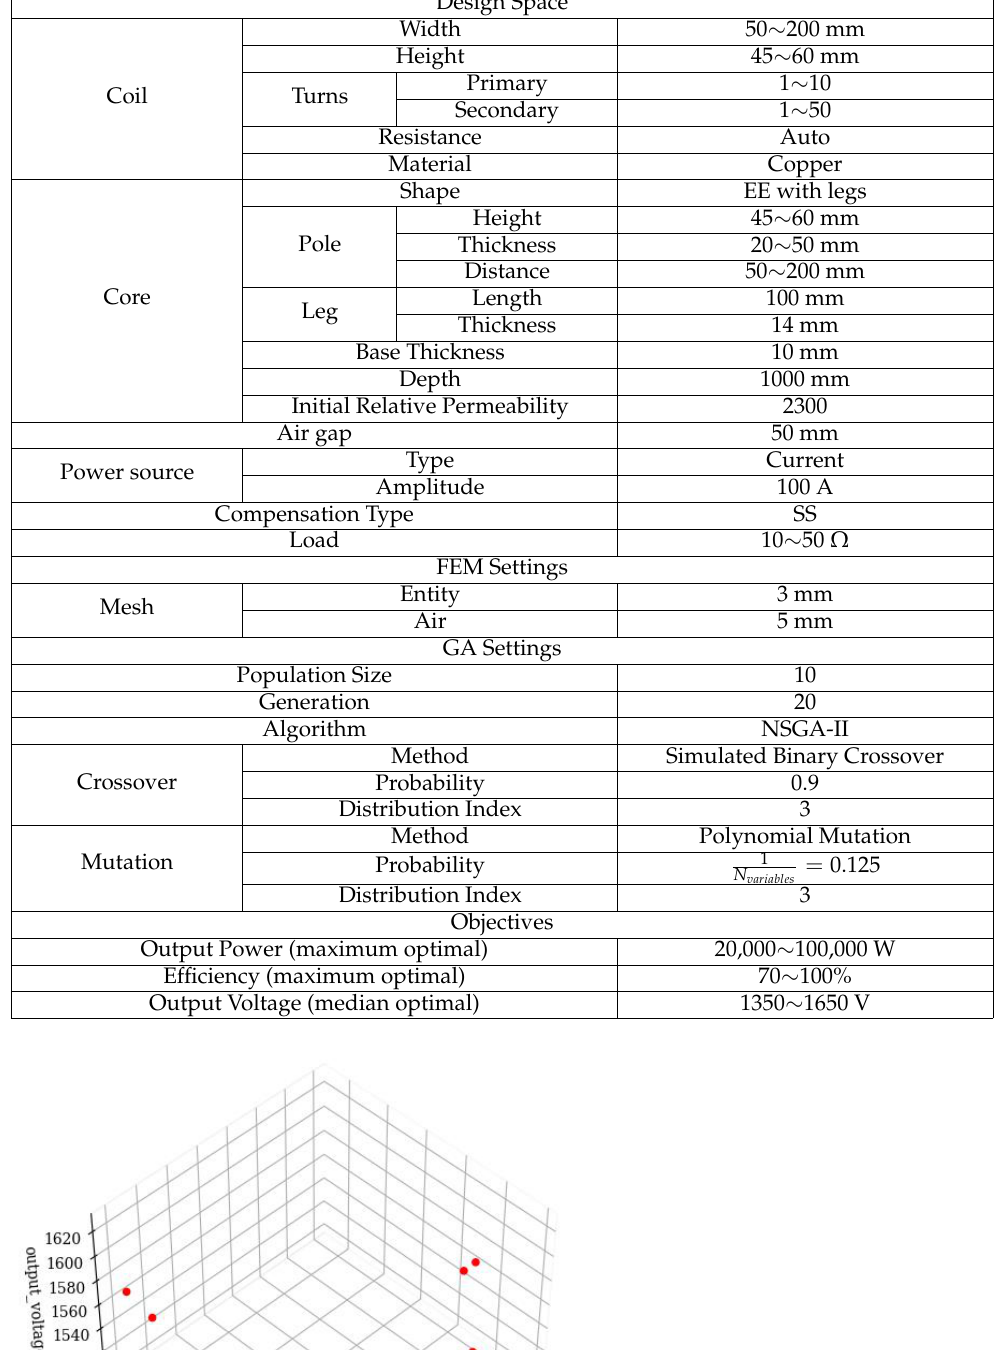
Table 3. The setting of optimal analysis mode example.